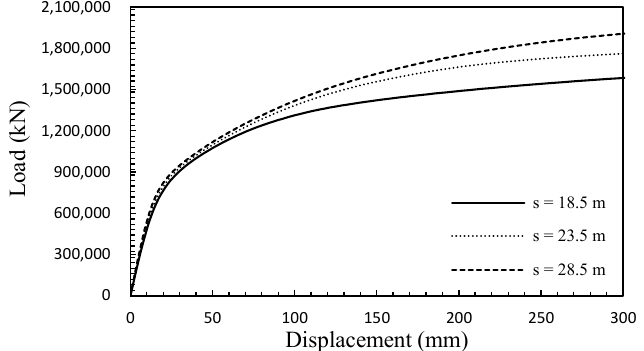
Figure 8. Load-horizontal displacement curve with anchorage spacing.